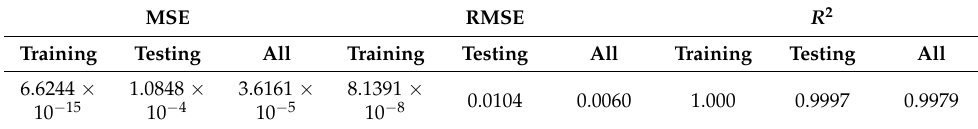
Table 4. The statistical assessment of the ANFIS model.